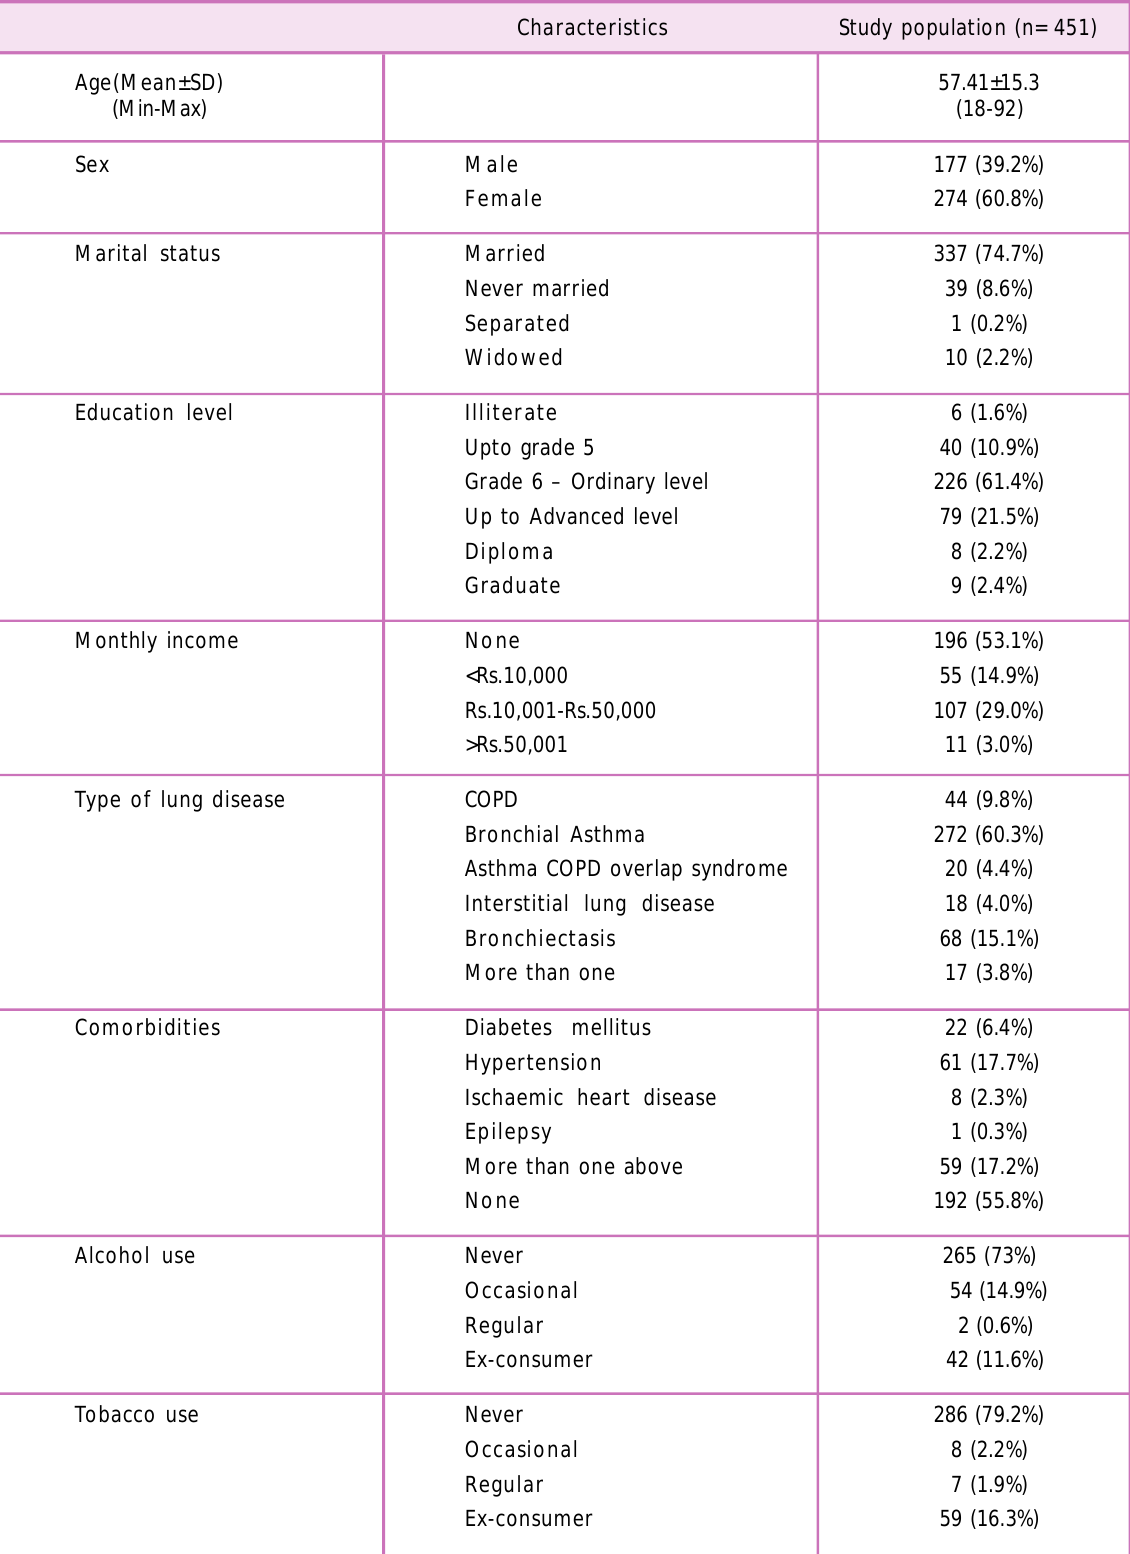
Table 1. Stigma among mental health professionals Table 1. Socio demographic and clinical characteristics of